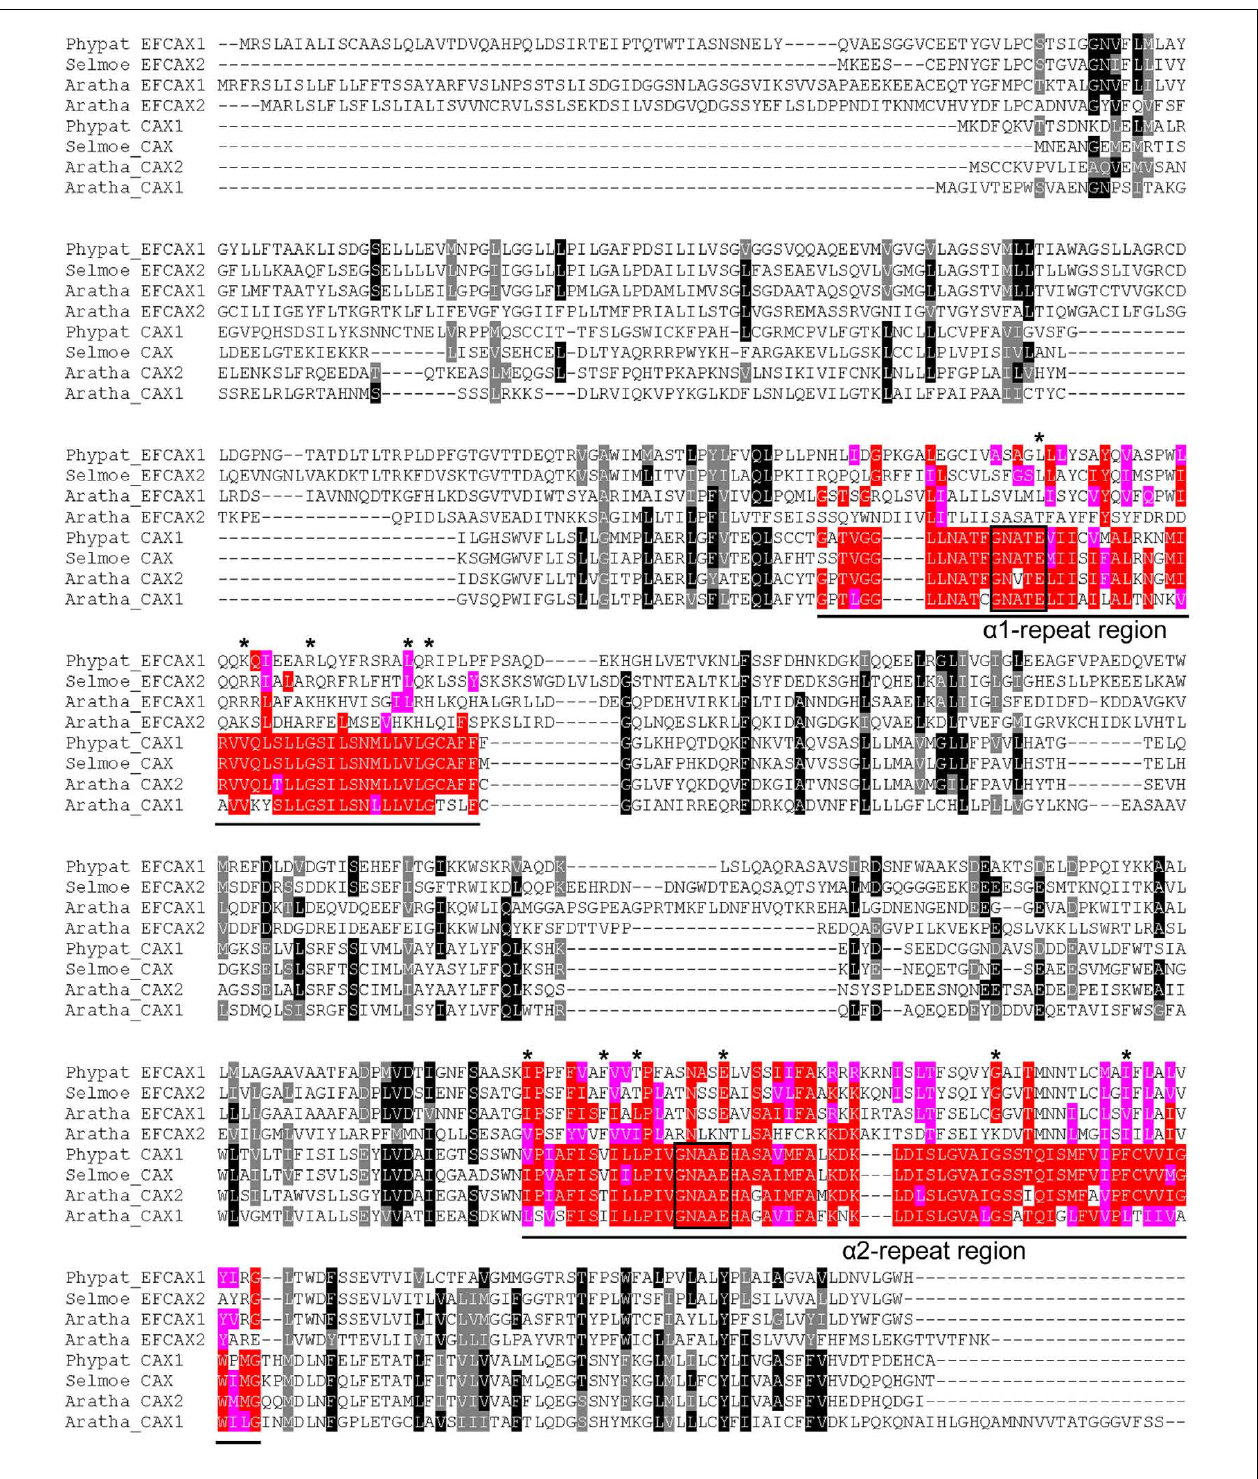
similar are shaded black/red or gray/pink, respectively.The α -repeat regions and signature residues are highlighted. Amino acids that are conserved in > 90% of CaCA proteins (Cai and Lytton, 2004a) are highlighted (asterisk) within the α 1- and α 2-repeat regions.